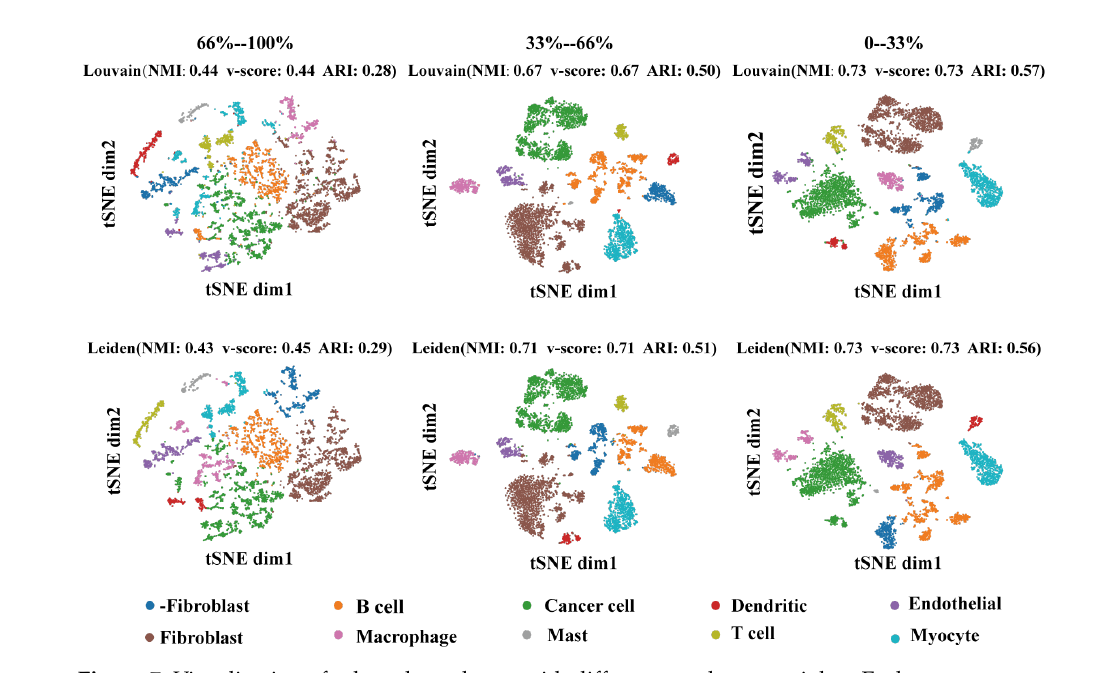
Figure 7. Visualization of selected regulators with different regulatory weights. Each row represents a clustering method ( top row : Louvain, bottom row : Leiden). Each column represents the regulatory weight of the selected data by ascending ranking. The dimension reduction method of the graph is